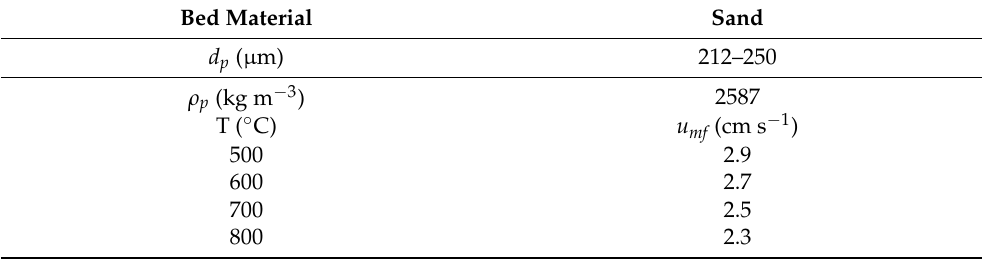
Table 1. Bed material physical properties of fluid-dynamic interest and minimum fluidization velocity ( u mf ) as a function of temperature at devolatilization conditions are described in Section